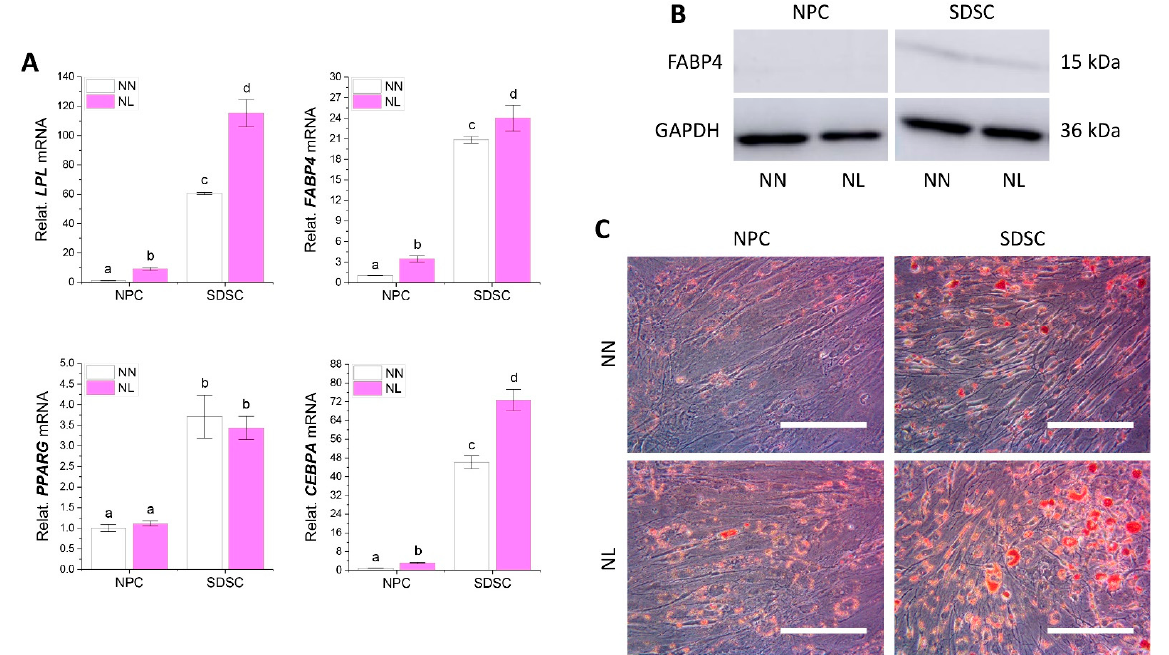
Figure 8. Evaluation of the effect of hypoxia on adipogenic differentiation of fetal MSCs. Normoxia expanded NPCs and SDSCs were incubated in adipogenic medium for 21 days in either normoxia (NN) or hypoxia (NL). RT-qPCR was used to evaluate the expression of adipogenic marker genes ( LPL , CEBPA , FABP4 , and PPARG ) ( A ), normalized against GAPDH levels as an internal control. Data ( n = 4) are represented in bar charts. Different letters indicate a statistically significant difference compared to the group within the same cell type ( p < 0.05). Western blot was used to assess the expression of the FABP4 protein ( B ). GAPDH served as an internal control. Oil Red O (ORO) staining was used to stain lipid droplets ( C ).